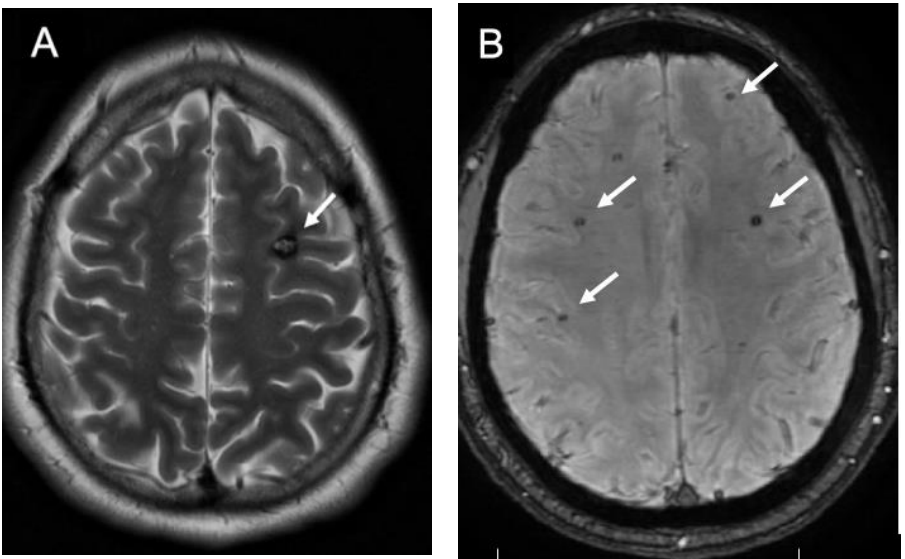
Figure 1. Nonoperative Asymptomatic CCMs. ( A ) patient with familial CCM and a left frontal lesion on T2 axial MRI (( A ), white arrow). The patient has numerous additional lesions identified as hypointensities seen best on gradient-echo sequences (representative arrows, ( B )). These lesions were not causing any symptoms and were monitored without intervention.